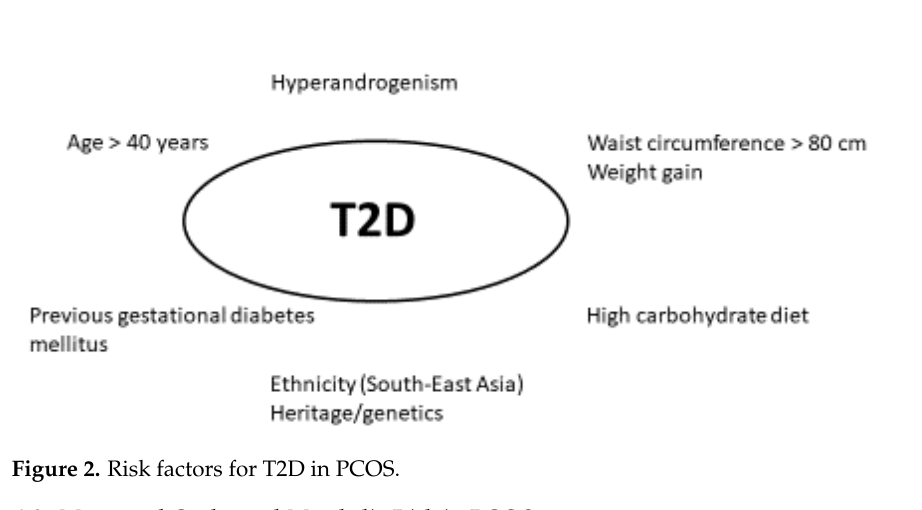
Figure 2. Risk factors for T2D in PCOS